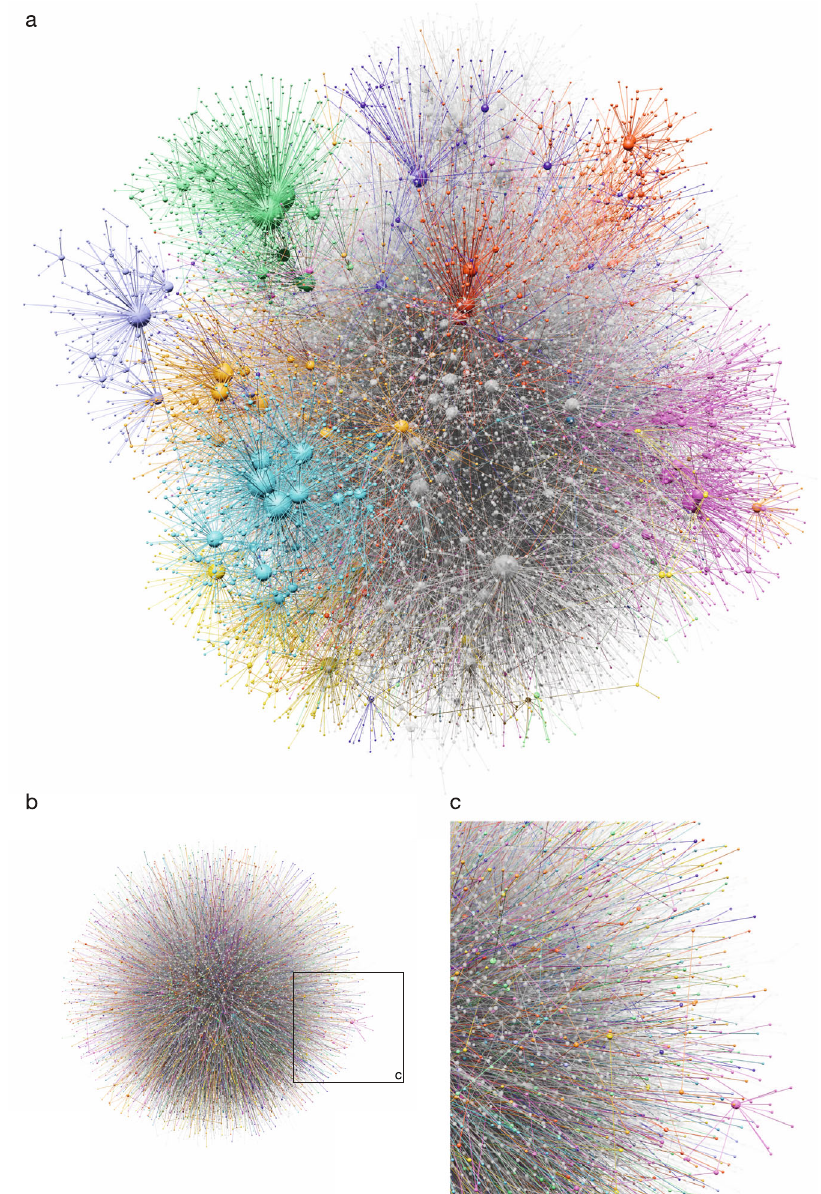
Fig. 4 | The 3D layout of the Internet. a The layout generated by NeuLay-2. We used the Louvain algorithm 32 to identify the community structure of the network and for visual clarity we highlight 12 communities in color. For a better view of the full 3D representation, see the video https://vimeo.com/732791412. b The FDL, by